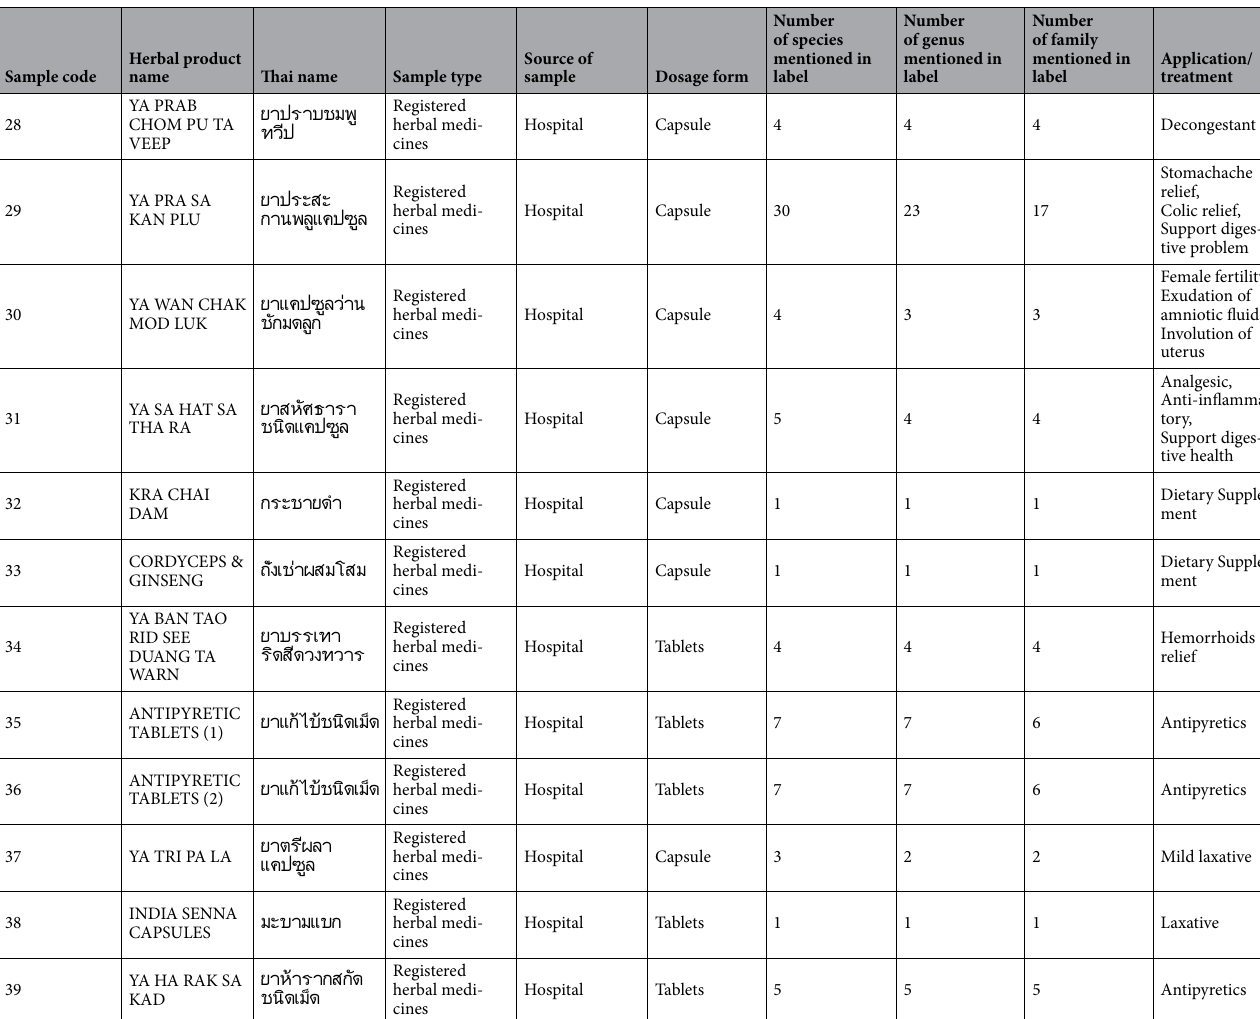
Table 1. Details of the Thai herbal products on the National List of Essential Medicines (NLEM) used in this